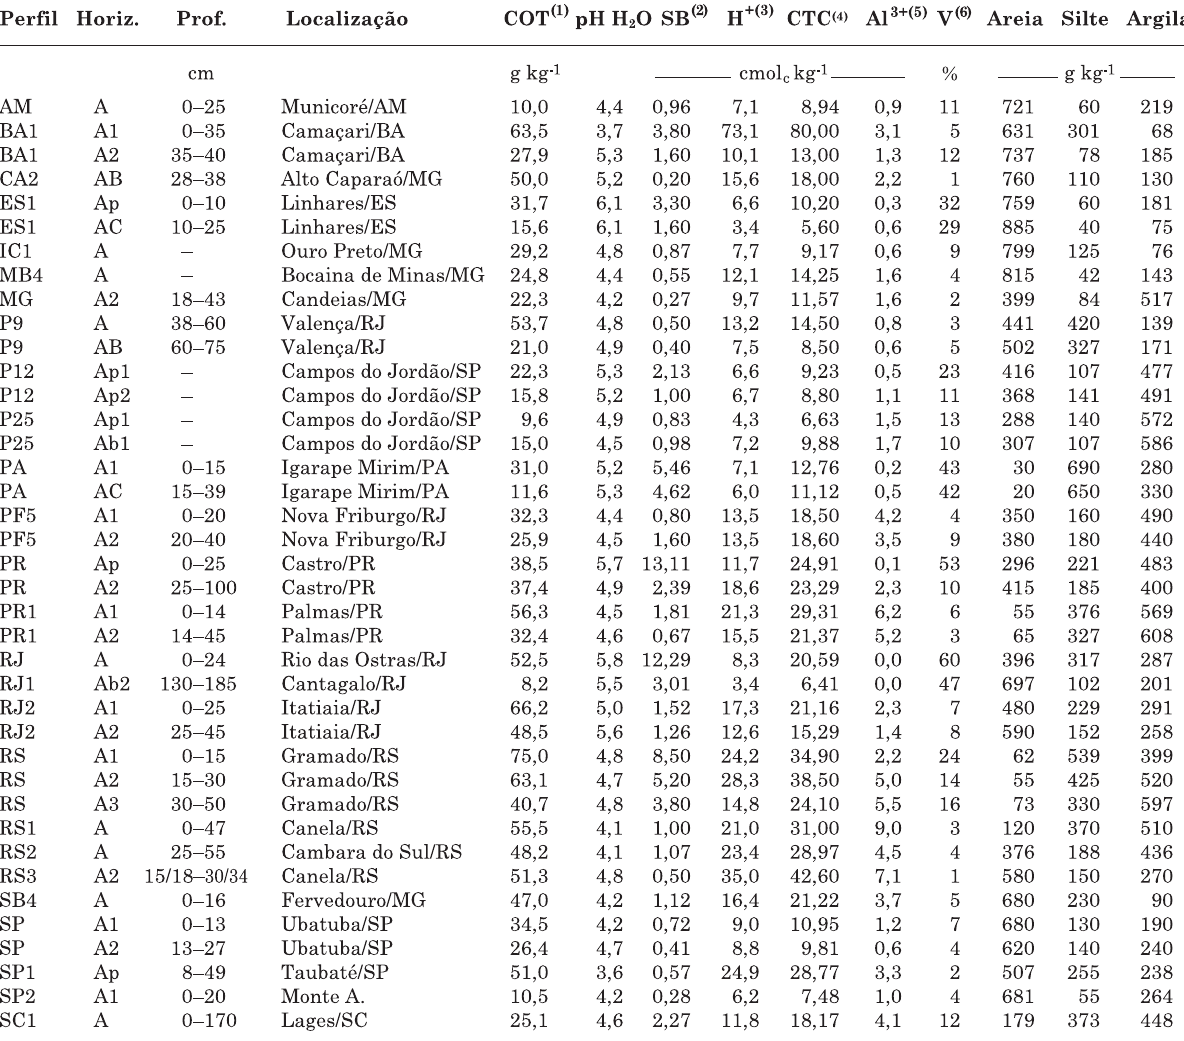
(1) COT: carbono orgânico total. (2) SB: soma de bases. (3) H + : hidrogênio trocável. (4) CTC: capacidade de troca de cátions. (5) Al 3+ : alumínio trocável. (6) V %: saturação por